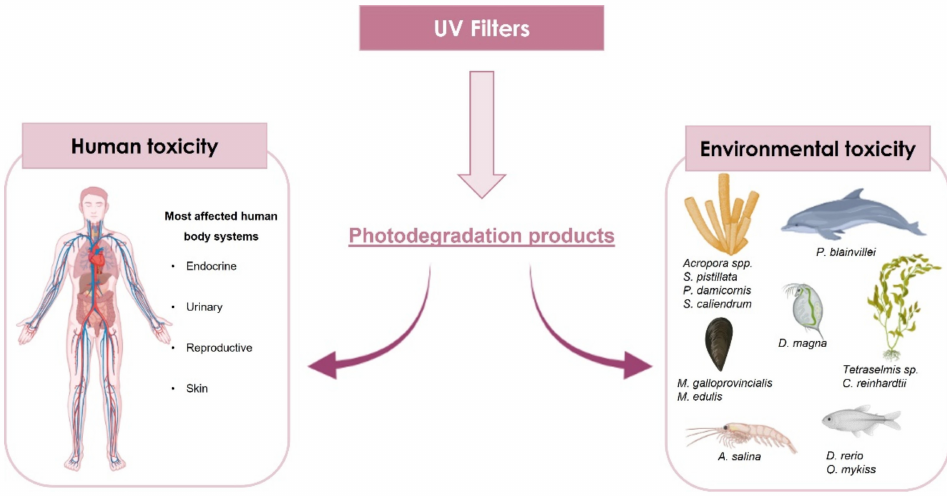
Figure 4. Resume of the main systems affected by UV filter’s